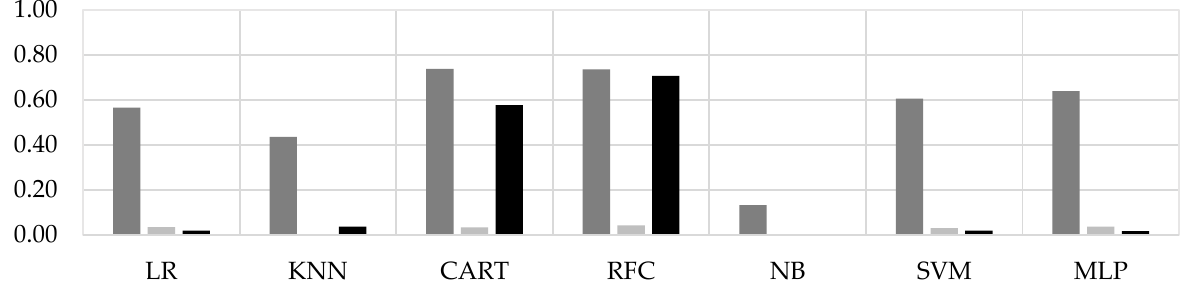
Figure 4. MCC for the FD model. The training system is the system on which the model is trained. The directly transferred system is the new system in which nothing is changed about the model or system. The transferred system with improved fault labels uses the original models, but has better fault labels. This figure is adapted from [65], Figures 7–9, which was published in the Energy journal, 198, G. Bode, S. Thul, M. Baranski, D. Müller, “Real-world application of machine-learning-based fault detection trained with experimental data”, 5–6, Copyright Elsevier